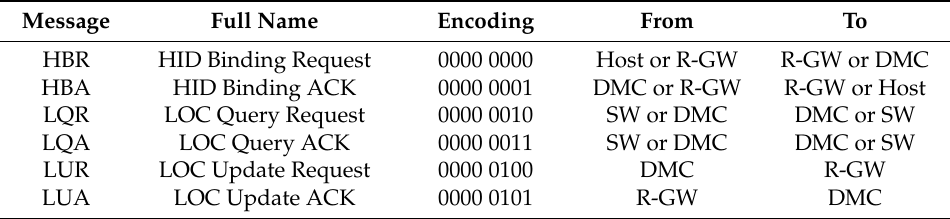
Table 3. Control messages. ACK—acknowledgement.